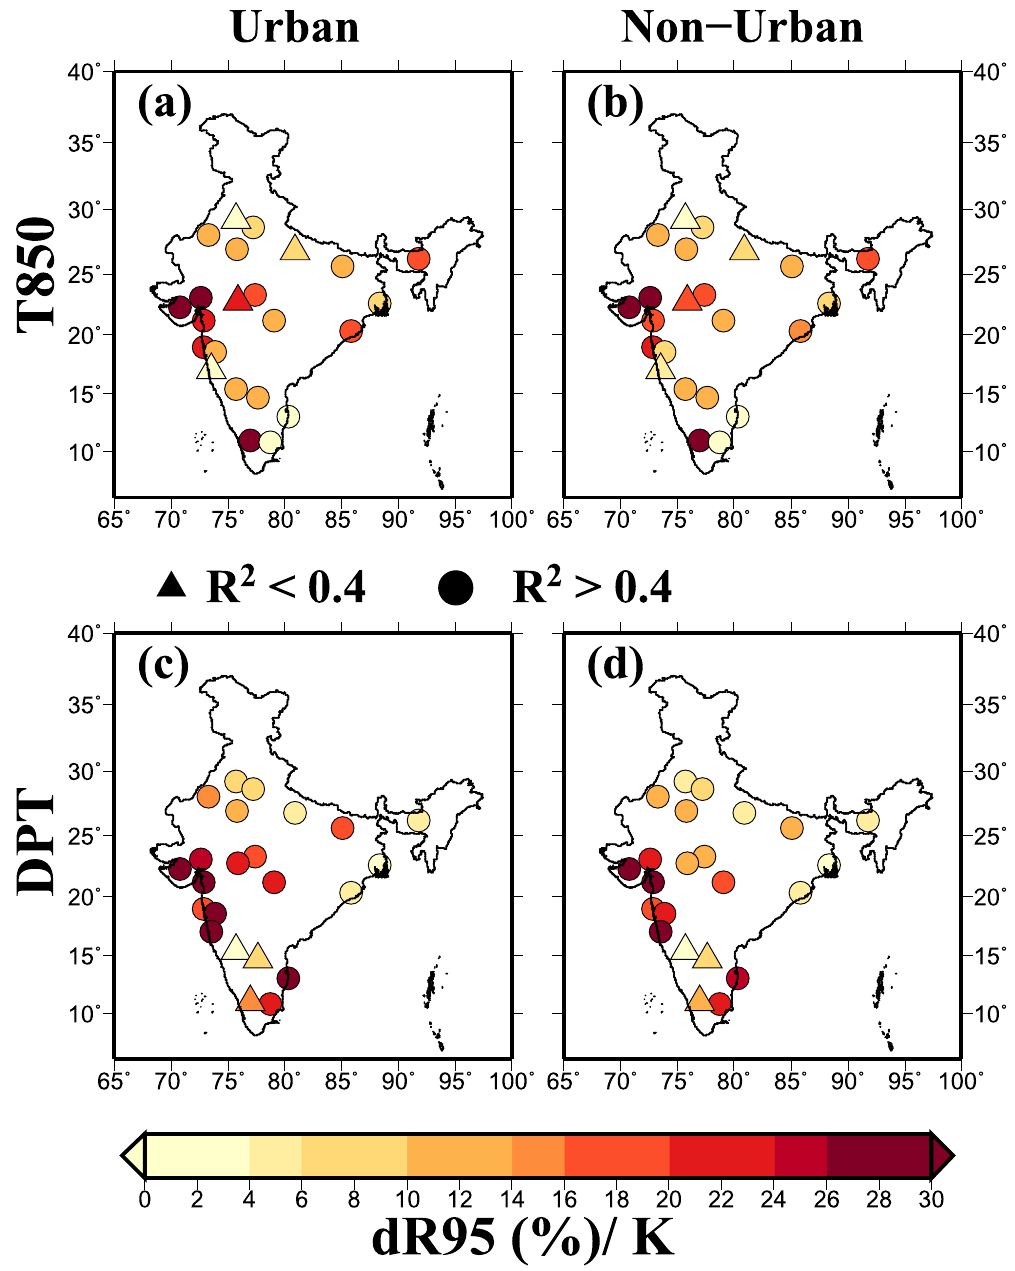
Figure 5. ( a , b ) Regression slopes (dR95/K, %) obtained from 3-hourly TRMM data using quantile regression (QR) at the 95th percentile for urban and surrounding non urban areas across India respectively, with daily air temperature at 850 hPa (T850), ( c , d ) same as ( a , b ) but for daily dewpoint temperature (DPT). Non-urban area around urban polygon was selected using 25 km buffer around urban polygon. The figure was developed using the Generic Mapping Tools (GMT,